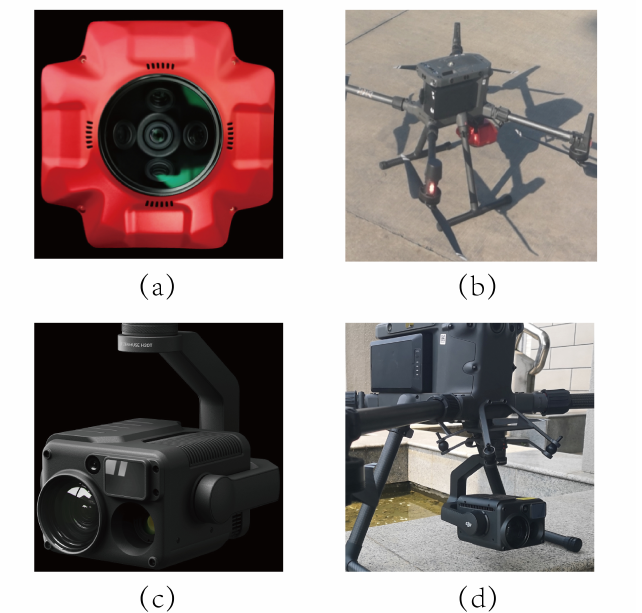
Figure 3. ( a ) Five-eye camera PDSK 102S. ( b ) DJI M300 with PDSK 102s. ( c ) DJI H20T. ( d ) DJI M300 with H20T.